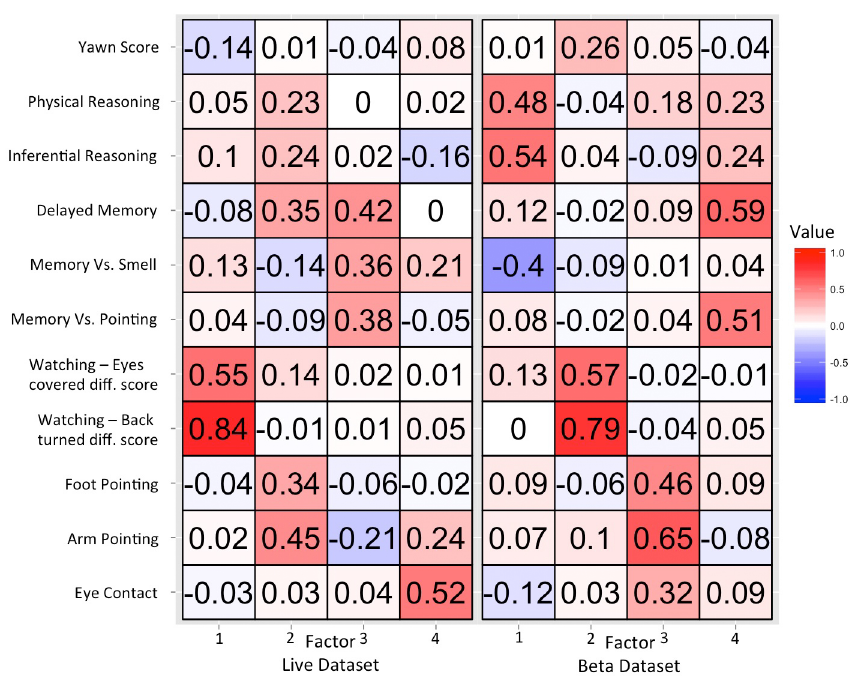
Fig 3. Factor loadings from exploratory factor analyses of the (A) Beta, and (B) Live datasets. Both datasets were best described by four factor models consisting of factors related to gesture comprehension, memory, and cunning, with a fourth factor that varied between the Beta an Live datasets. The order of factors varied between datasets but the following factors resemble one another between analyses (Live PA1 & Beta PA2; Live PA2 & Beta PA3; Live PA3 & Beta PA4. The remaining factors (Live PA4 & Beta PA1) had no clear analog in the other dataset.